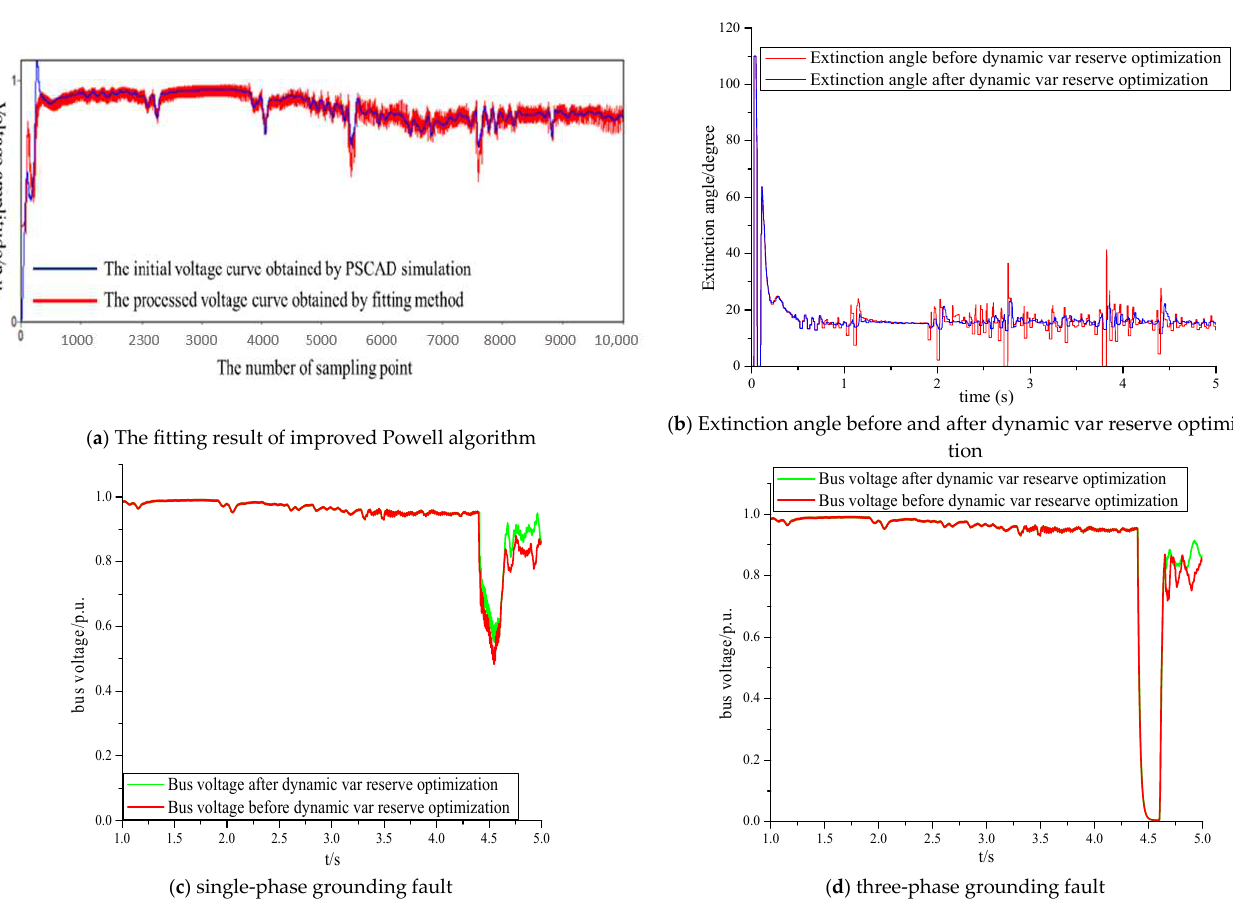
Figure 7. Effectiveness and feasibility of the proposed method.